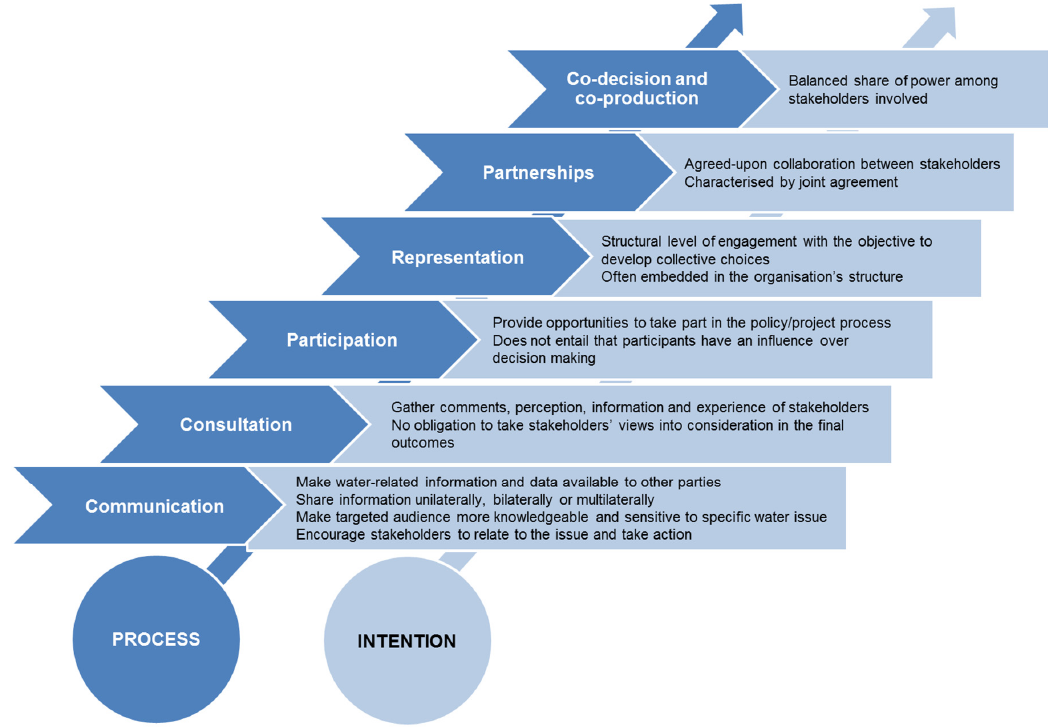
Figure 1. Organisation for Economic Co-operation and Development (OECD) typology of levels of stakeholder engagement [23].